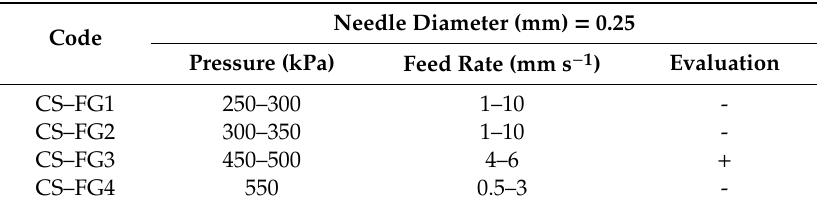
Table 2. Summary of the 3D printing trials.